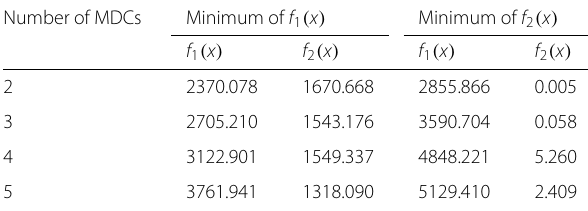
Table 5 Performance analysis of proposed algorithm for different MDCs using the